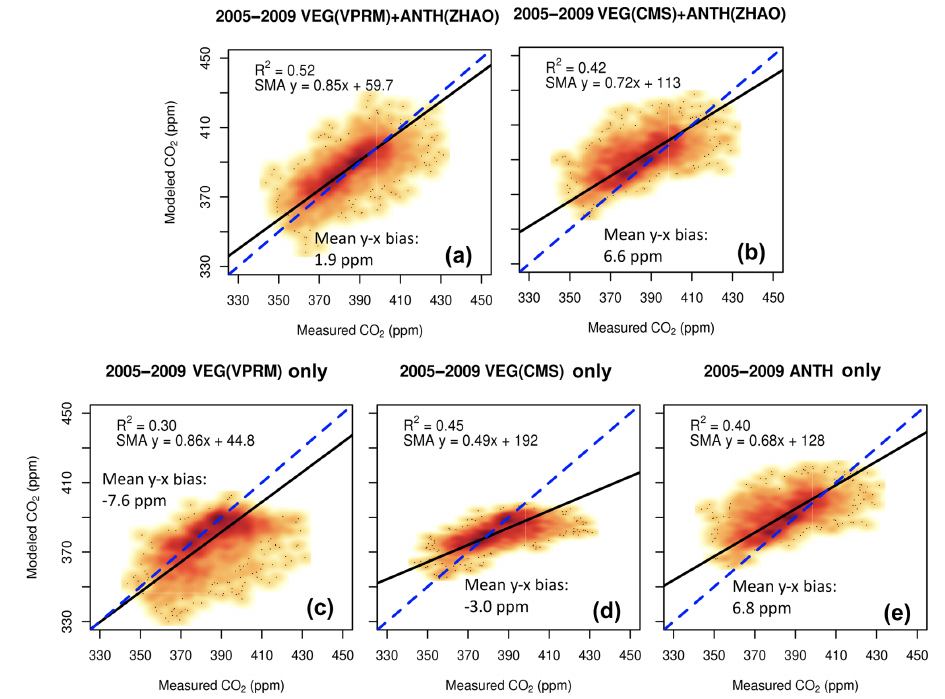
Figure 9. Smoothed scatter plots examining relative impact of excluding anthropogenic and vegetation influences in modeling growing- season CO 2 . (a) Both hourly anthropogenic and VPRM-CHINA NEE included; (b) both hourly anthropogenic and 3-hourly CMS NEE; (c) hourly VPRM-CHINA NEE only; (d) 3-hourly CMS NEE only; (e) hourly anthropogenic only. All modeled inventories are unoptimized. The blue dashed line represents the 1 : 1 line; the solid black line represents the SMA fit line described by the equations displayed. Higher point density is represented by darker colors.